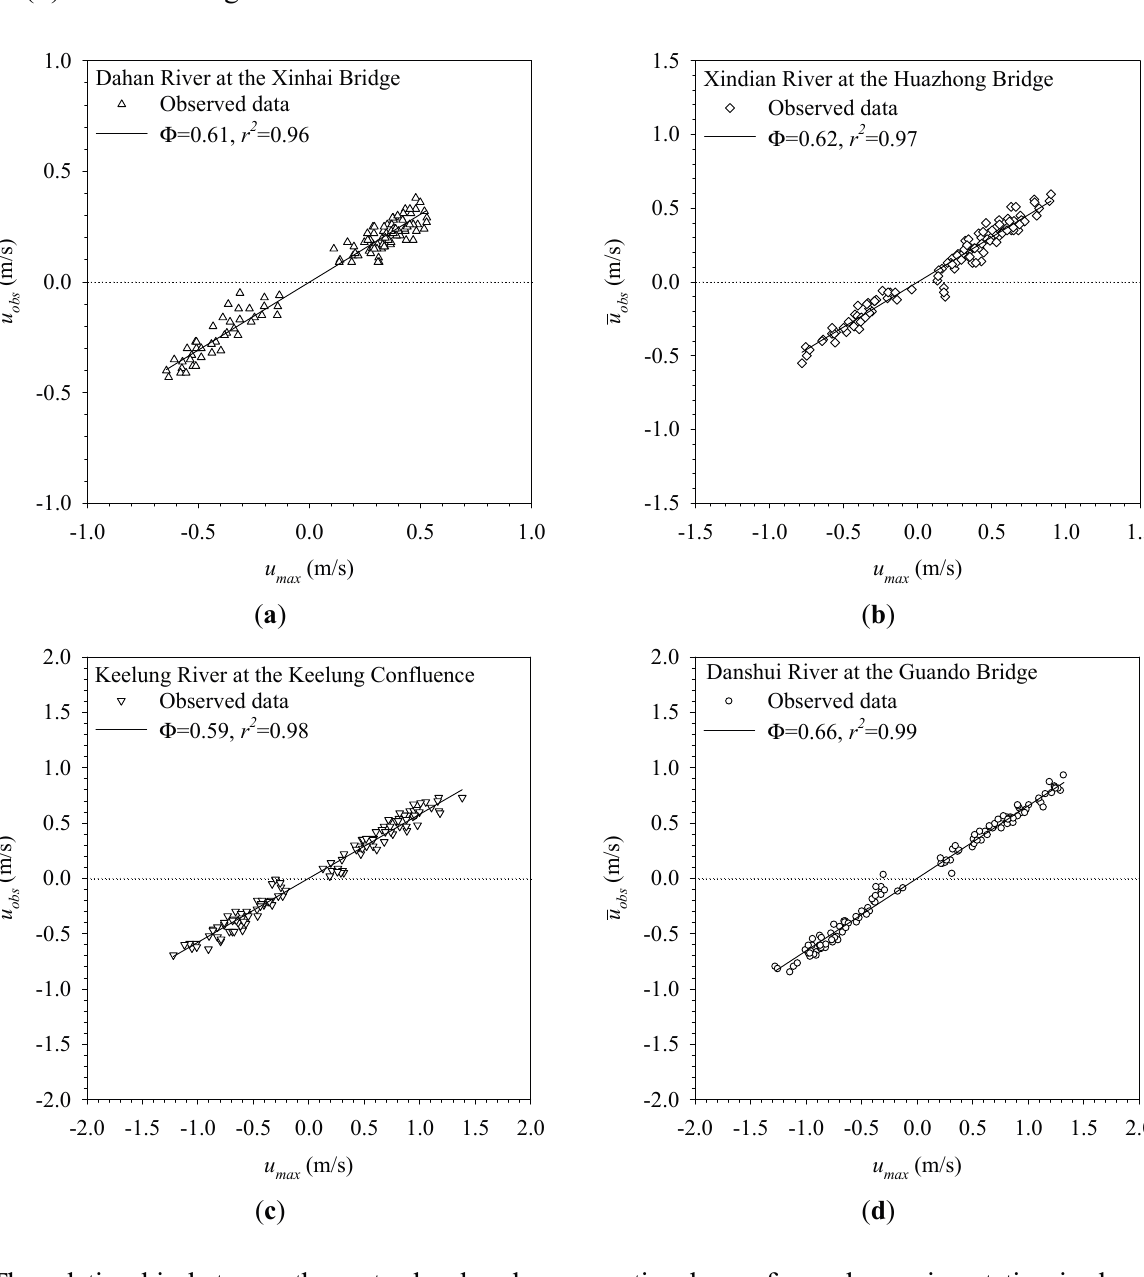
Figure 4. Relation of maximum and mean velocities in the gauging station network during the calibration phase: ( a ) Xinhai Bridge; ( b ) Huazhong Bridge; ( c ) Keelung Confluence; ( d ) Guando Bridge.